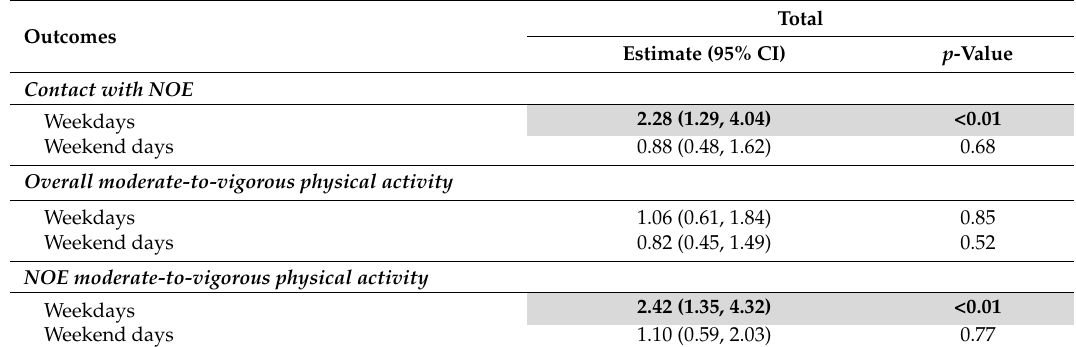
Table A5. Sensitivity models. Adjusted models for residential NOE availability defined as presence/ absence of green spaces at 300 m network buffer excluding